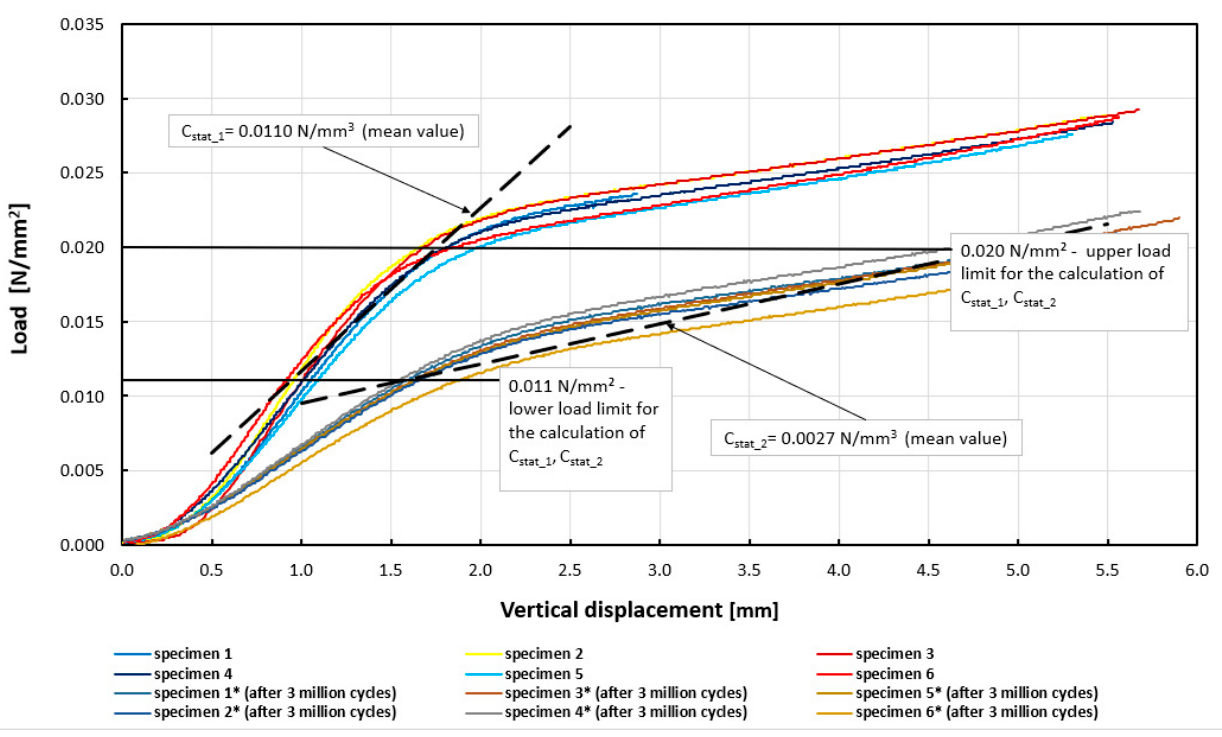
Figure 4. Experimental curves (load vs. displacement) for determining C stat_1 , C stat_2 moduli for Mat B. Table 4. Experimental results of the static bedding modulus C stat for Mat B.